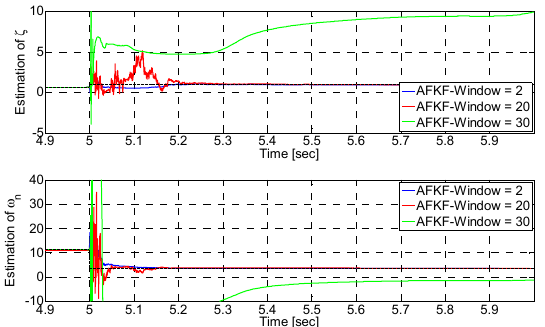
ff erent window